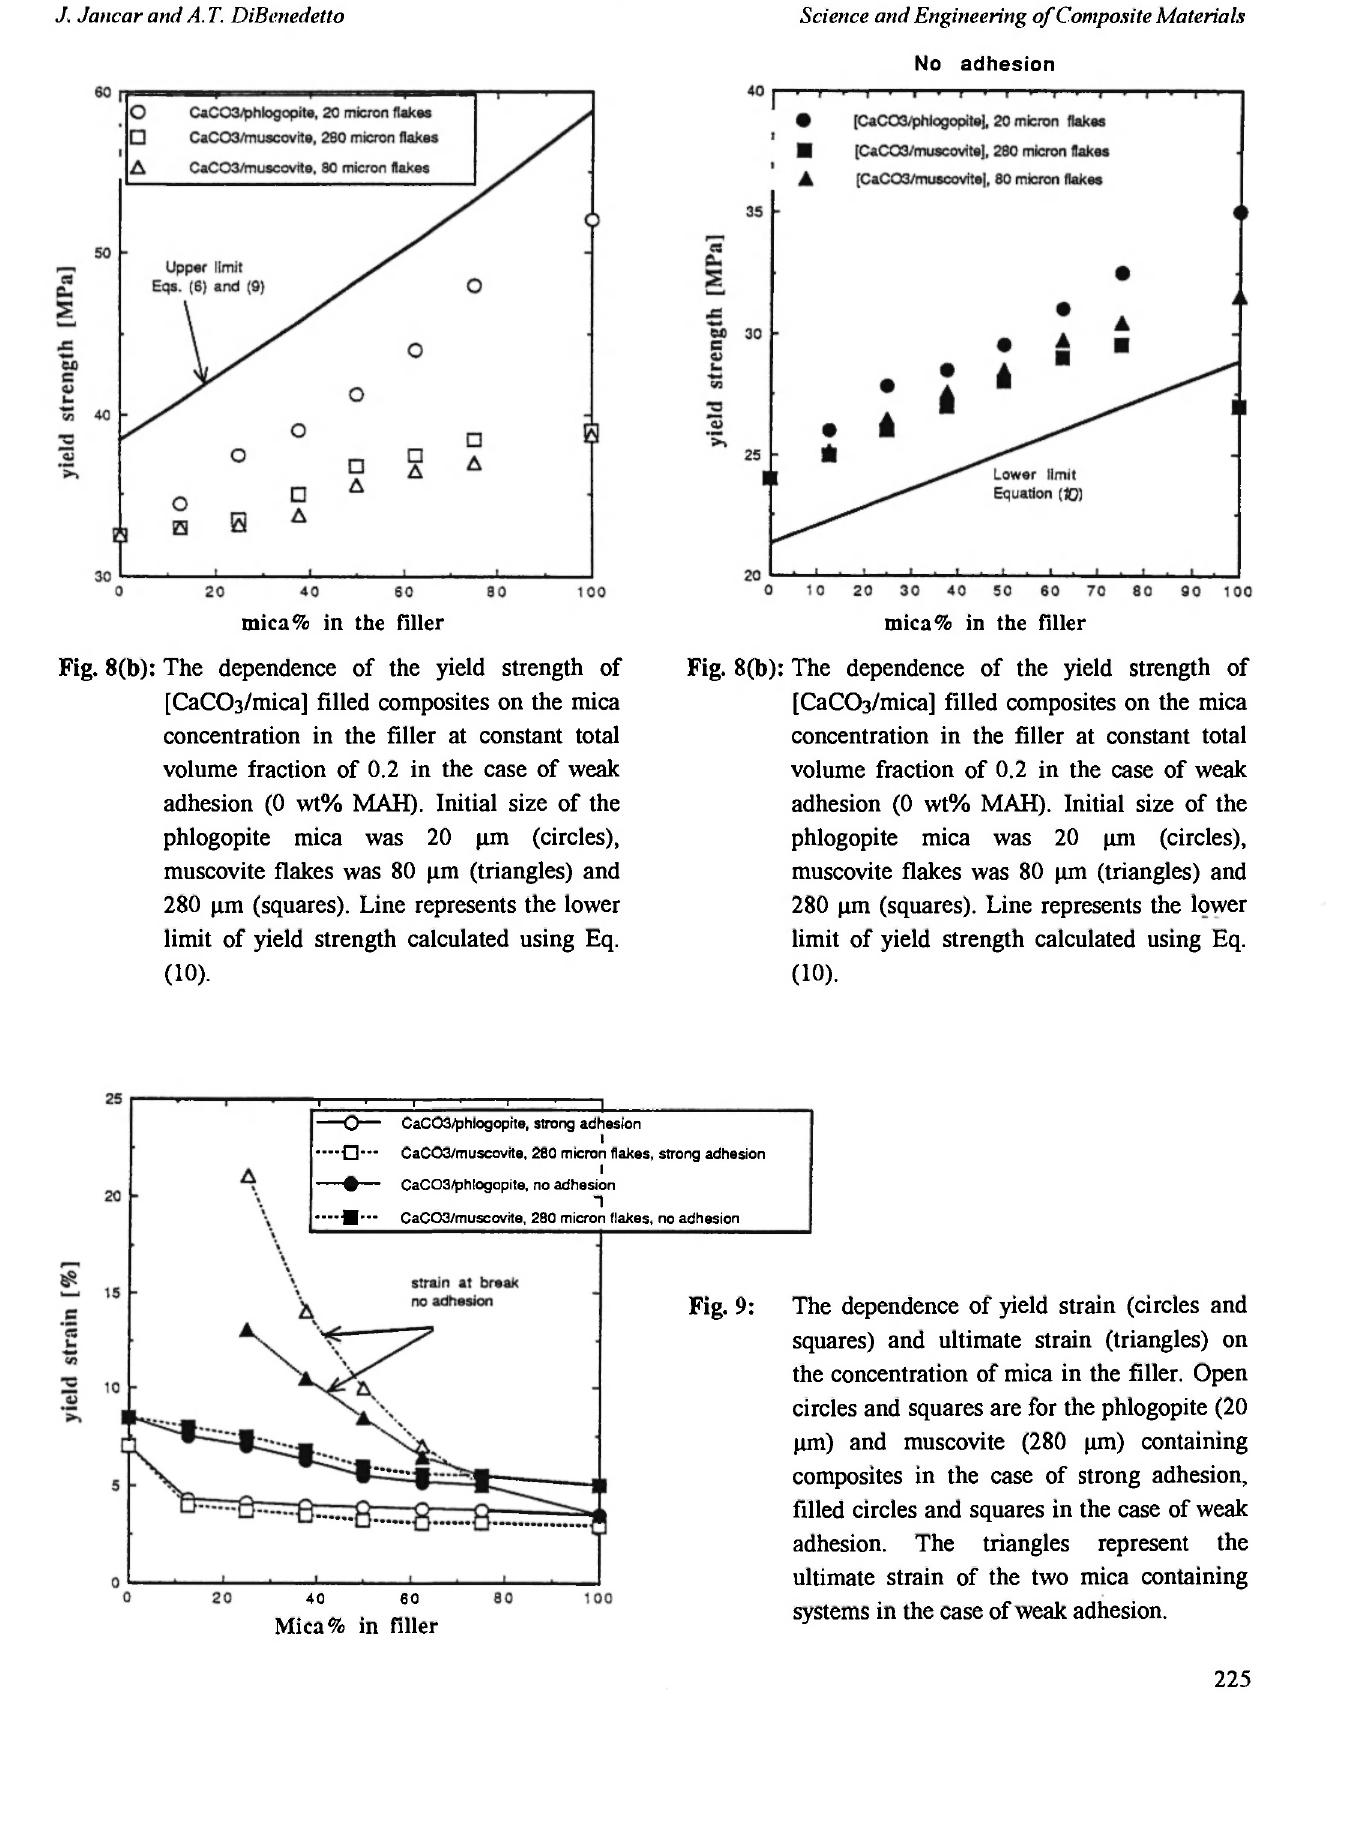
Fig. 8(b): The dependence of the yield strength of [CaCC^/mica] filled composites on the mica concentration in the filler at constant total volume fraction of 0.2 in the case of weak adhesion (0 wt% ΜΑΗ). Initial size of the phlogopite mica was 20 μπι (circles), muscovite flakes was 80 μπι (triangles) and 280 μπι (squares). Line represents the lower limit of yield strength calculated using Eq. (10).